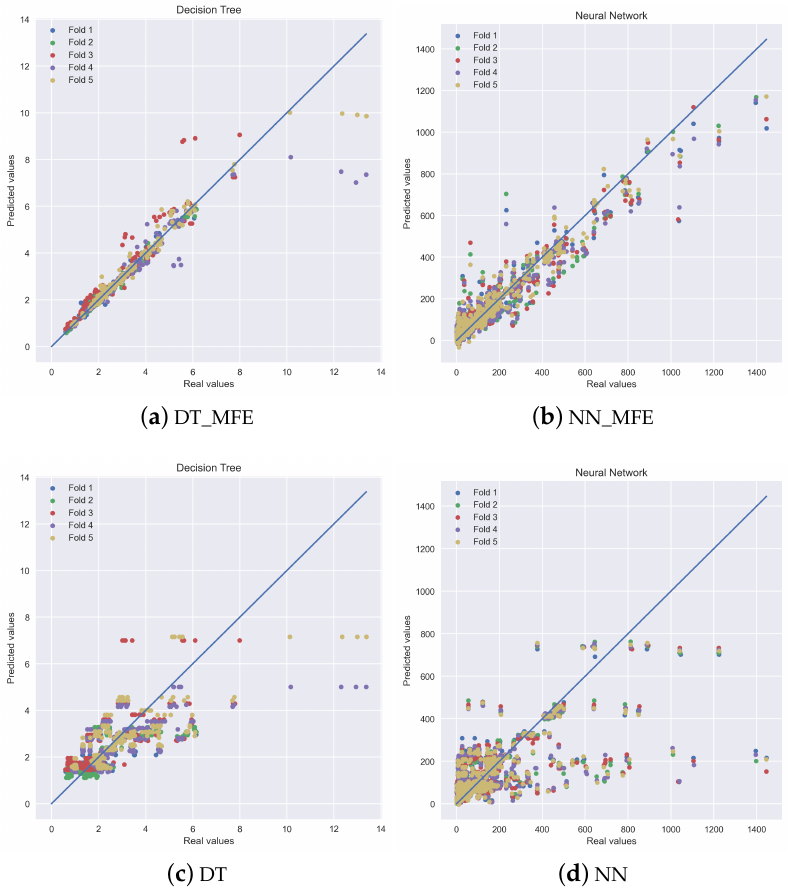
Figure 4. Scatter plots showing the real vs. predicted durations (in seconds) for the Decision Tree and Neural Network algorithms, with ( top ) and without ( bottom ) meta-features, with the five folds